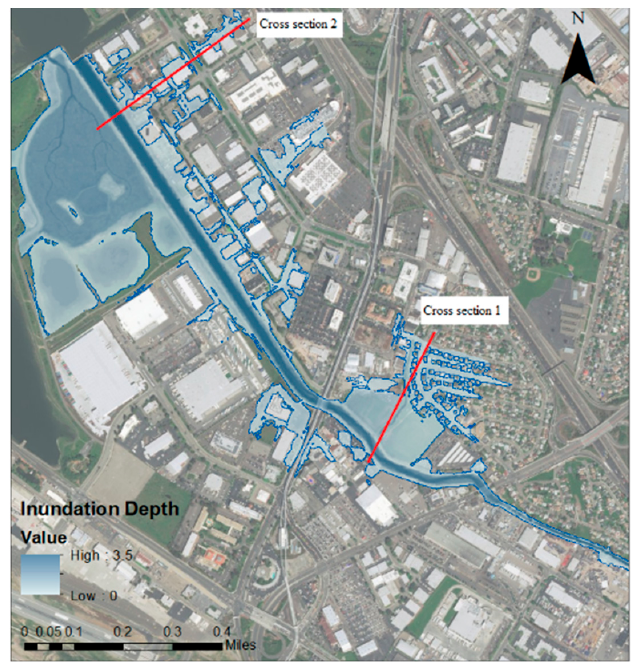
Figure 8. Blue area shows compound impacts of high tide (1.94 m), 1m SLR, groundwater inundation, and 2-year precipitation. Cross sections 1 and 2 are visualized in Figure 9.